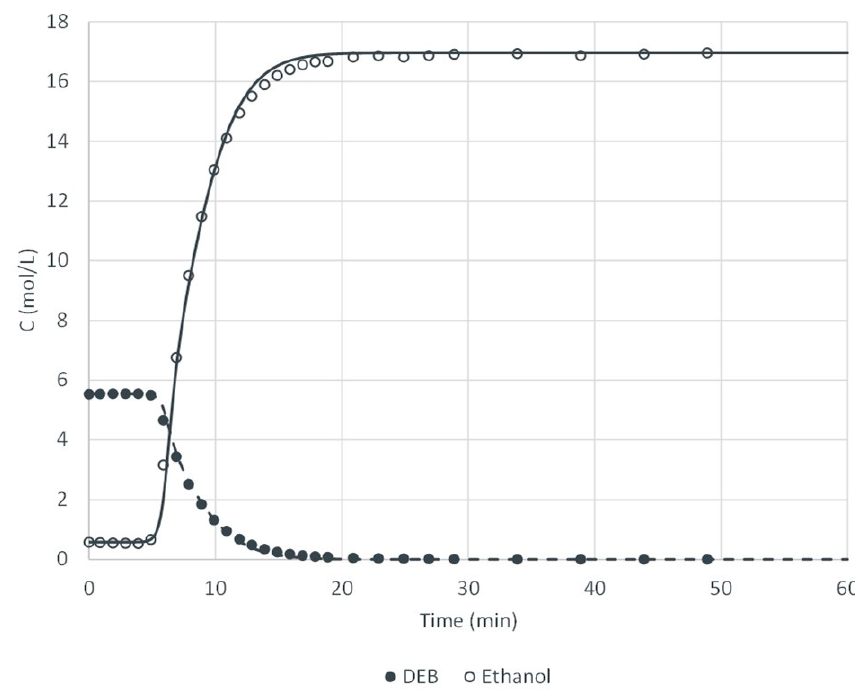
Figure 4. Breakthrough curve between ethanol and DEB experimental conditions provided in Table 2 for experiment 1 [22].